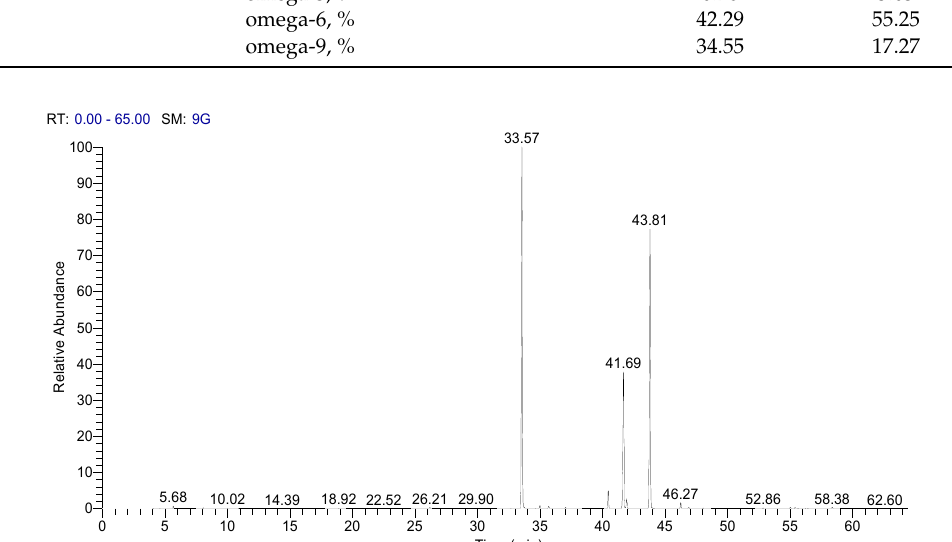
Figure 3. Spectra of GC–MS of fatty acid methyl esters of sorghum. Appl. Sci. 2020 , 10 , x FOR PEER REVIEW